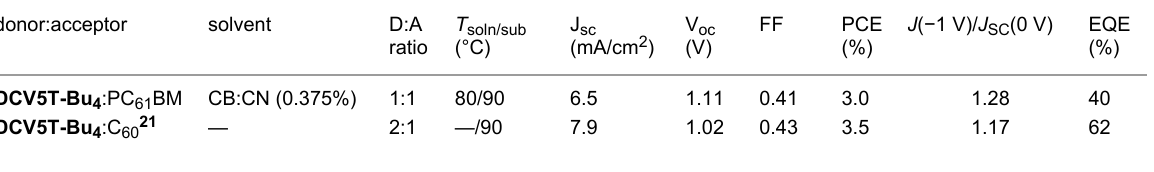
Table 3: Comparing vacuum [21] and solution-processed active layers of optimized solar cells fabricated from DCV5T-Bu 4 . Solution-processed device structure: ITO|PEDOT:PSS| DCV5T-Bu 4 :PC 61 BM|LiF|Al.